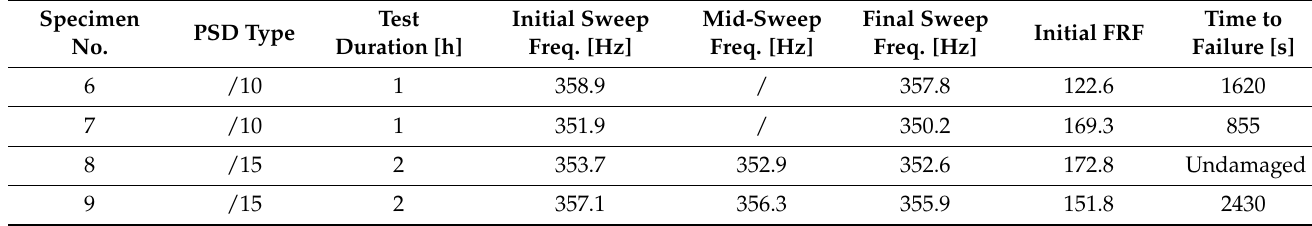
Table 9. Random tests result for the Diamond lattice specimens.